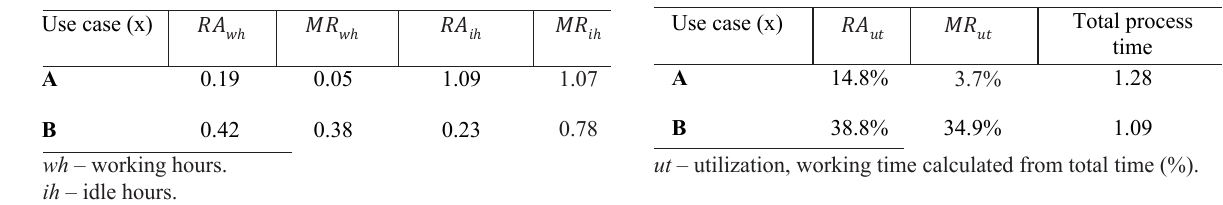
Table 2. Working and idle hours of RA and MR Table 3. Utilization of RA and